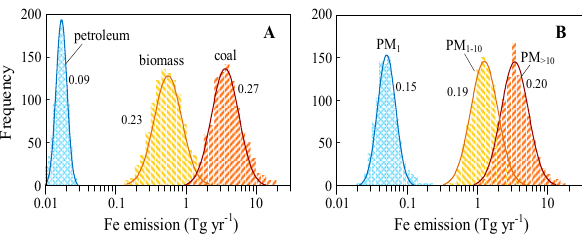
Figure 1 . Figure 1. Frequency distributions of Fe emissions from different fuel types (a) and particle sizes (b) . The distributions are derived from 1000 Monte Carlo simulations. The standard deviation of log 10 -transformed Fe emissions is shown for each distribution. The x -axis is plotted on a log